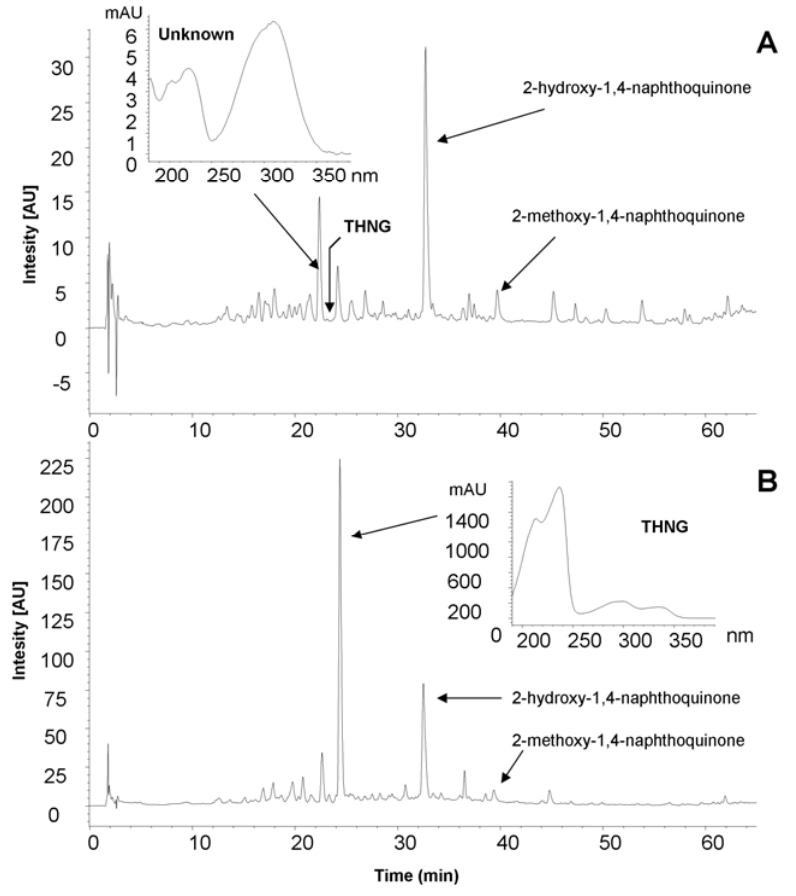
Figure 1. The chromatographic profile (HPLC) of methanolic extracts prepared from the roots of Impatiens glandulifera Royle dried at room temperature ( A ) and lyophilized roots ( B ).